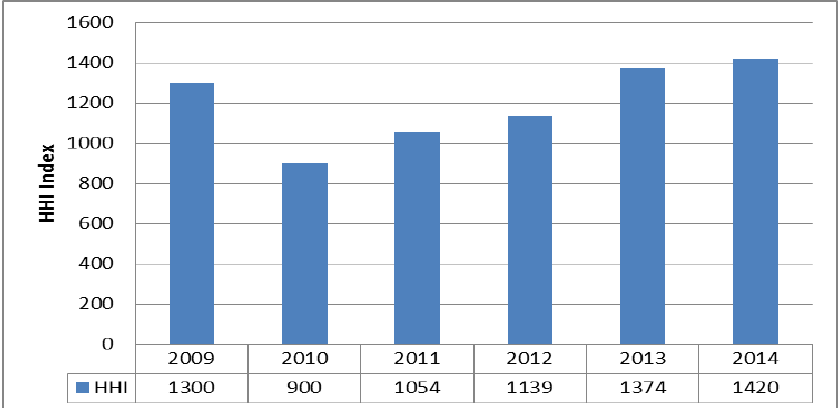
FIGURE 1: Evolution of the HHI Source: Researcher’s own